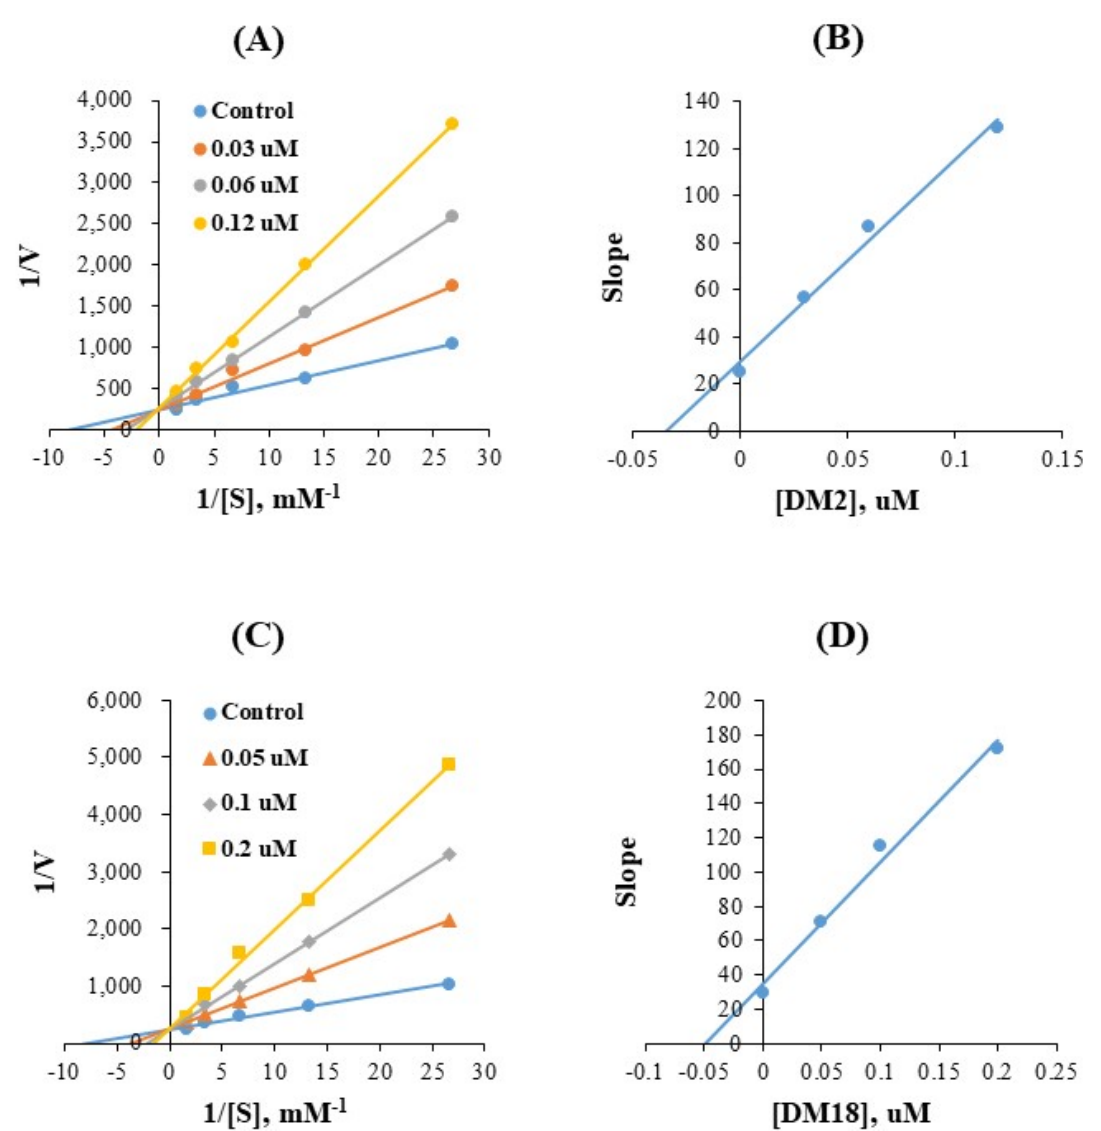
Figure 3. LB plots for MAO-B inhibition by DM2 and DM18 ( A , C ), and their secondary plots ( B , D ) of the slopes vs. inhibitor concentrations.